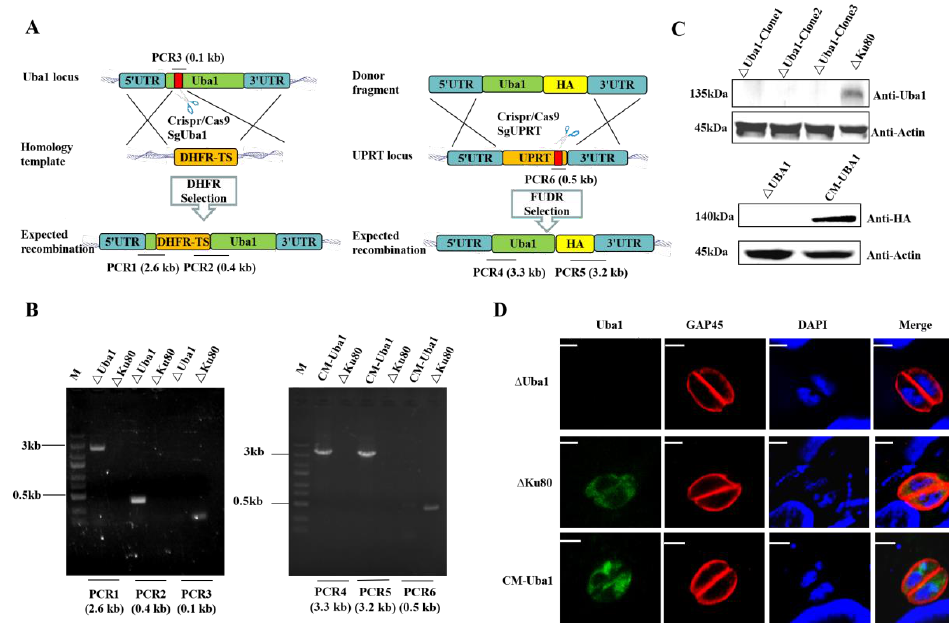
Figure 4. Construction of TgUba1 gene editing strains. ( A ) Schematic diagram of CRISPR/CAS9- mediated disruption of knockout and complementary strain construction. The red bar indicated the sgRNA target region. ( B ) PCR verification of TgUba1 deletion and complementation. PCR1, PCR2 and PCR4, PCR5 checked for 5 ′ and 3 ′ integration of the selection marker, while PCR3 and PCR6 examined successful deletion and complementation of TgUba1 gene. ( C ) Western blot verification of deletion and complementation of TgUba1. ( D ) IFA verification of TgUba1 loss and complemen- tation. PVs were marked in red by rabbit anti-GAP45 polyclonal antibody, while TgUba1 was marked in green by anti- TgUba1 polyclonal antibody. Scale bar, 2.5 μm .